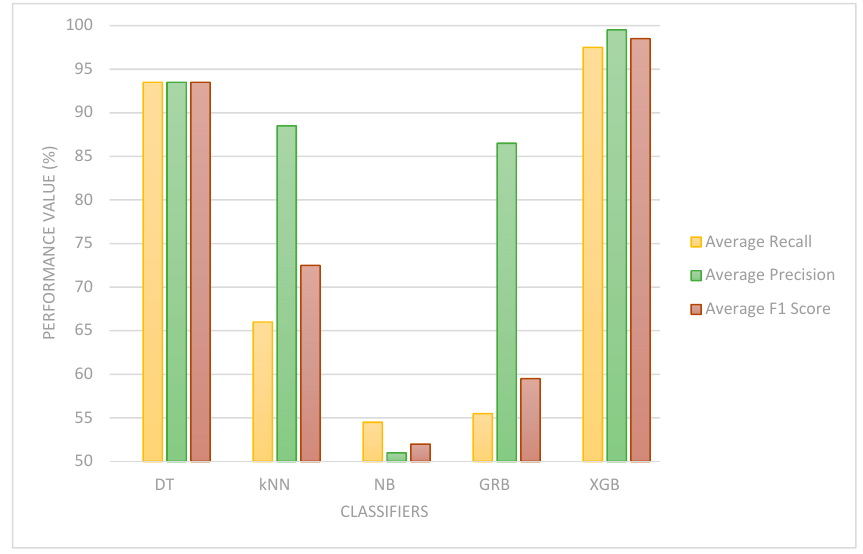
Figure 8. Average performance of classifiers (normal and attack instances).